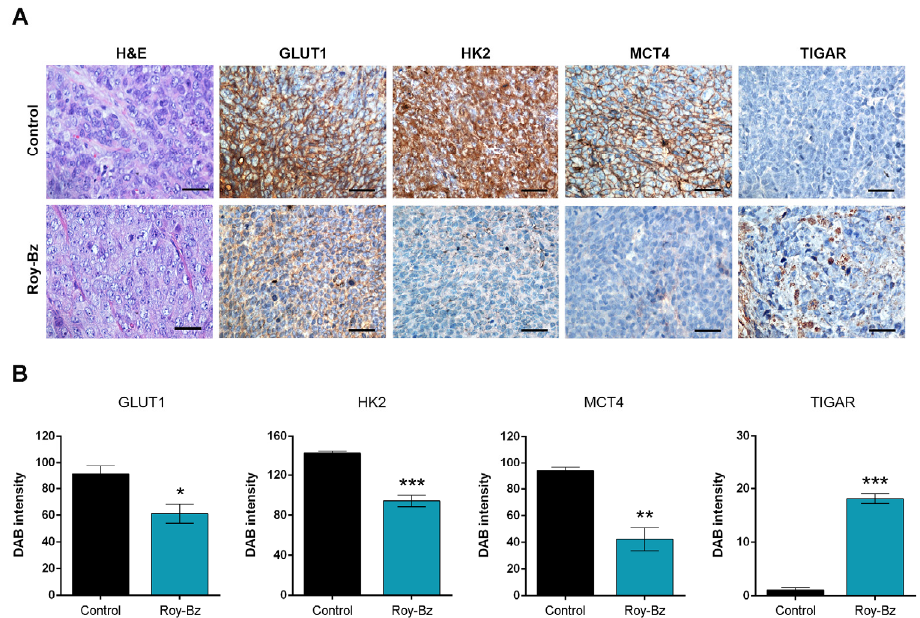
Figure 6. Roy-Bz reduces the levels of proteins involved in glycolysis in tumor tissues of human colon xenograft mouse models. ( A ) Representative images of IHC of glycolytic markers (GLUT1, HK2, MCT4, and TIGAR) detected in tumor tissues of HCT116 xenografts treated with 10 mg/kg Roy-Bz or vehicle (control) and collected at the end of the treatment (scale bar =5 μ m; magnification = ×400; H&E). ( B ) Quantification of immunohistochemistry staining of HCT116 xenograft tumor tissues was assessed by evaluation of DAB intensity. Data are mean ± SEM; values significantly different from control (* p < 0.05, ** p < 0.01, *** p < 0.001), unpaired Student’s t -test.